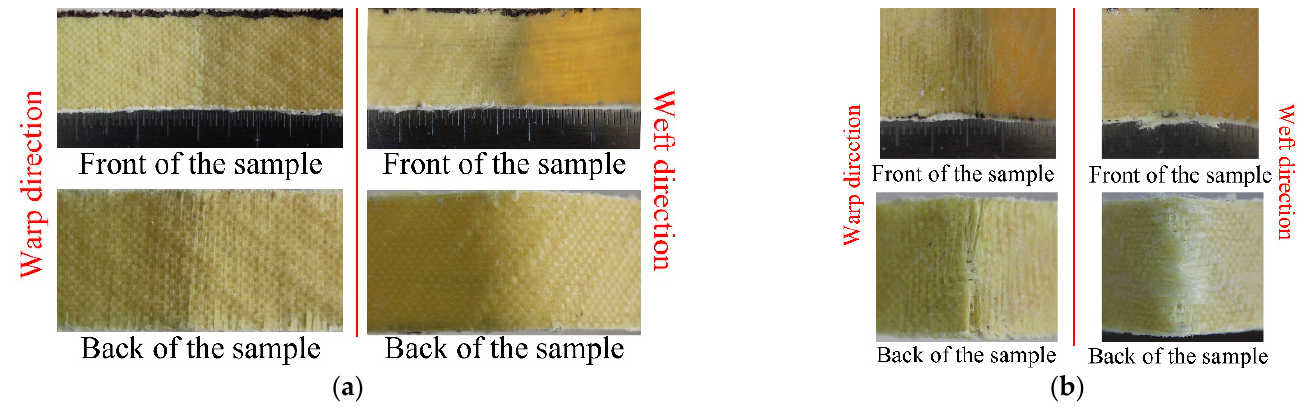
Figure 3. Bending failure morphologies of 3DDAI of Kevlar/EP armor materials with 1 to 2 layers. ( a ) 1 layer. ( b ) 2